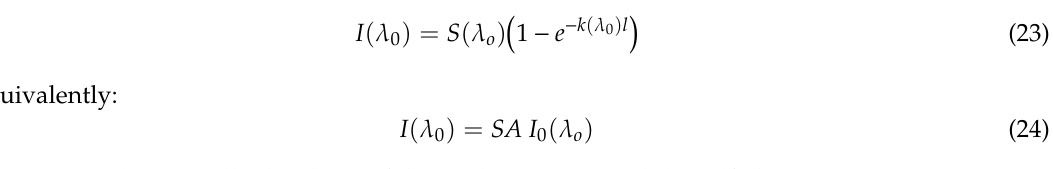
Figure 5. Determination of the unknown A ki of a spectral line from the knowledge of the composition of the sample.